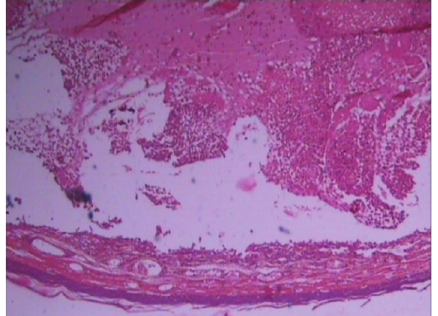
Figure 2: Excision of the lesion using electrocautery.